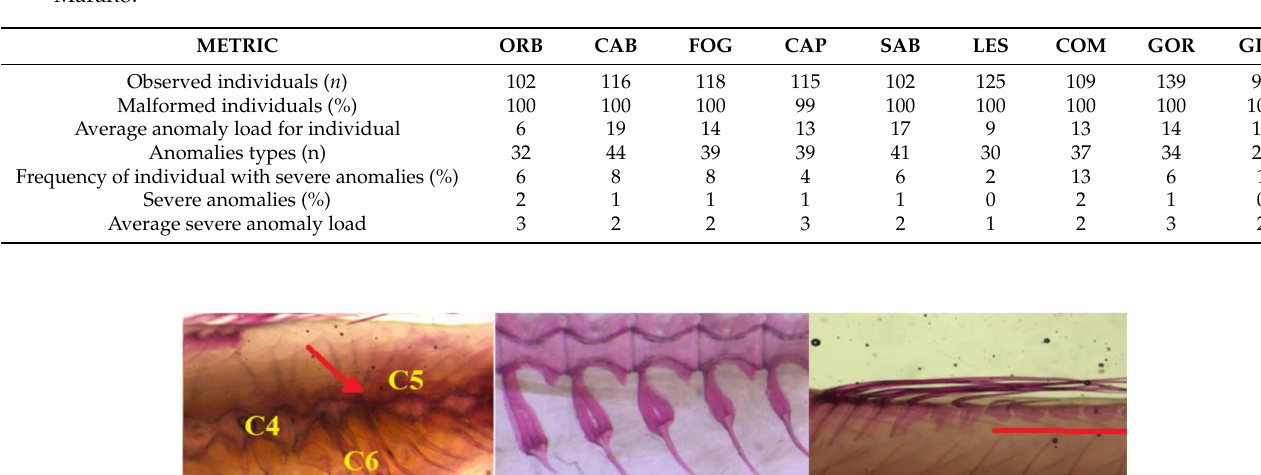
Table 4. Metrics from skeletal anomalies analysis in the nine samples of A. boyeri . Sites: (ORB) Orbetello, (CAB) Cabras, (FOG) Fogliano, (CAP) Caprolace, (SAB) Sabaudia, (LES) Lesina, (COM) Comacchio, (GOR) Sacca di Goro, (GRA) Grado Marano.